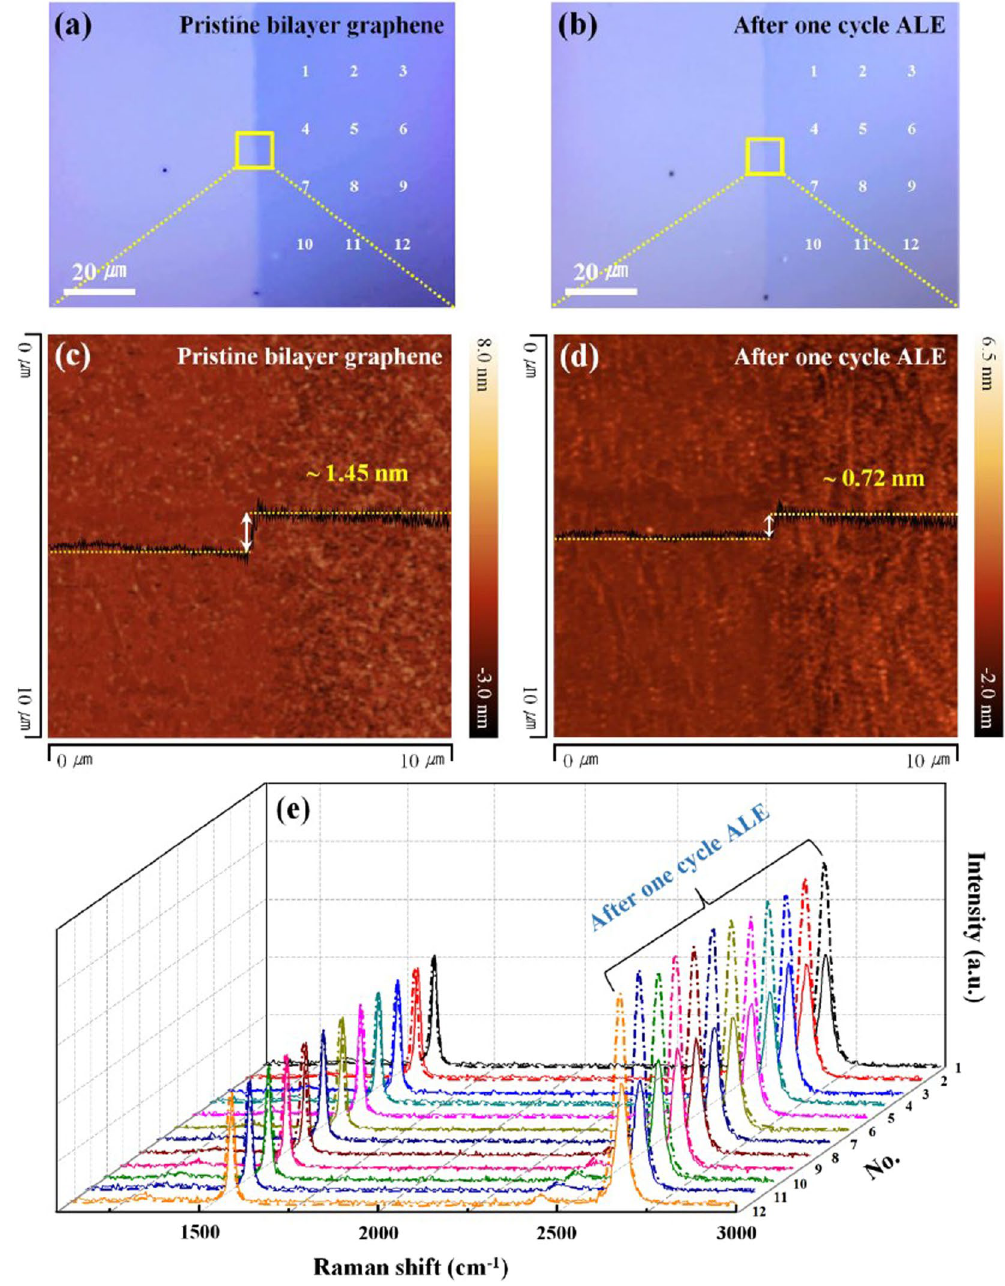
Figure 6. Comparision of bilayer graphene at the same position after one cycle ALE. ( a and b ) Optical images of the pristine bilayer graphene before and after one cycle ALE, respectively. ( c and d ) AFM images of the same sample before and after one cycle ALE, respectively, for the position denoted by the yelloew square in ( a ) and ( b ). ( e ) Change of the Raman spectroscopic data of the pristine bilayer graphene after one cycle ALE for the positions of 1~12 in ( a and b